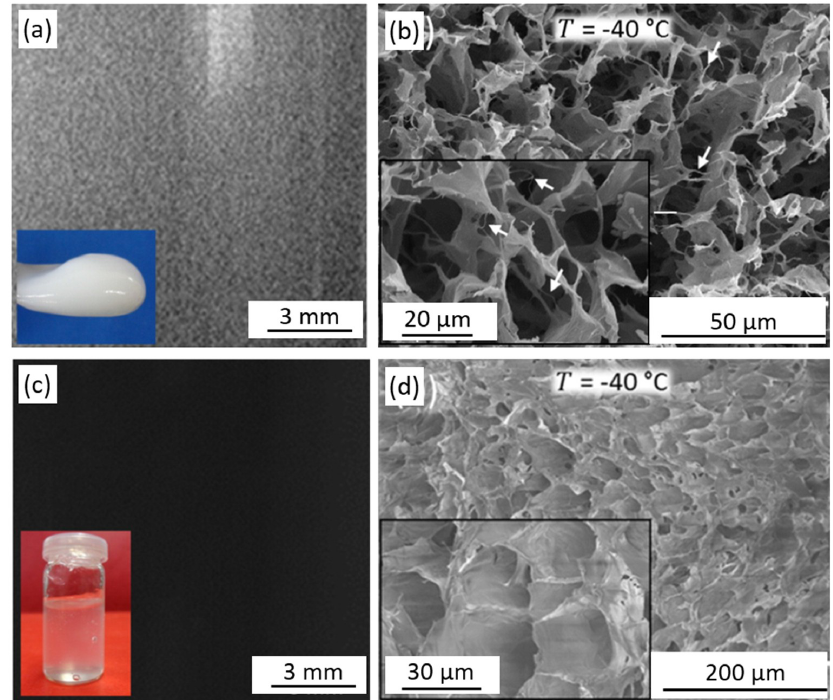
Figure 13. Photographs obtained with a black background of a 2‐wt% enzymatic CNF suspension ( a ), and a 0.75‐wt% TEMPO‐oxidised CNF suspension ( c ). SEM micrographs of enzymatic CNF foams ( ≃ 23 kg m −3 ) ( b ) and TEMPO‐oxidised CNF foams ( ≃ 11 kgm −3 ) ( d ). (Adapted from Martoïa et al. [56] with permission from Elsevier).